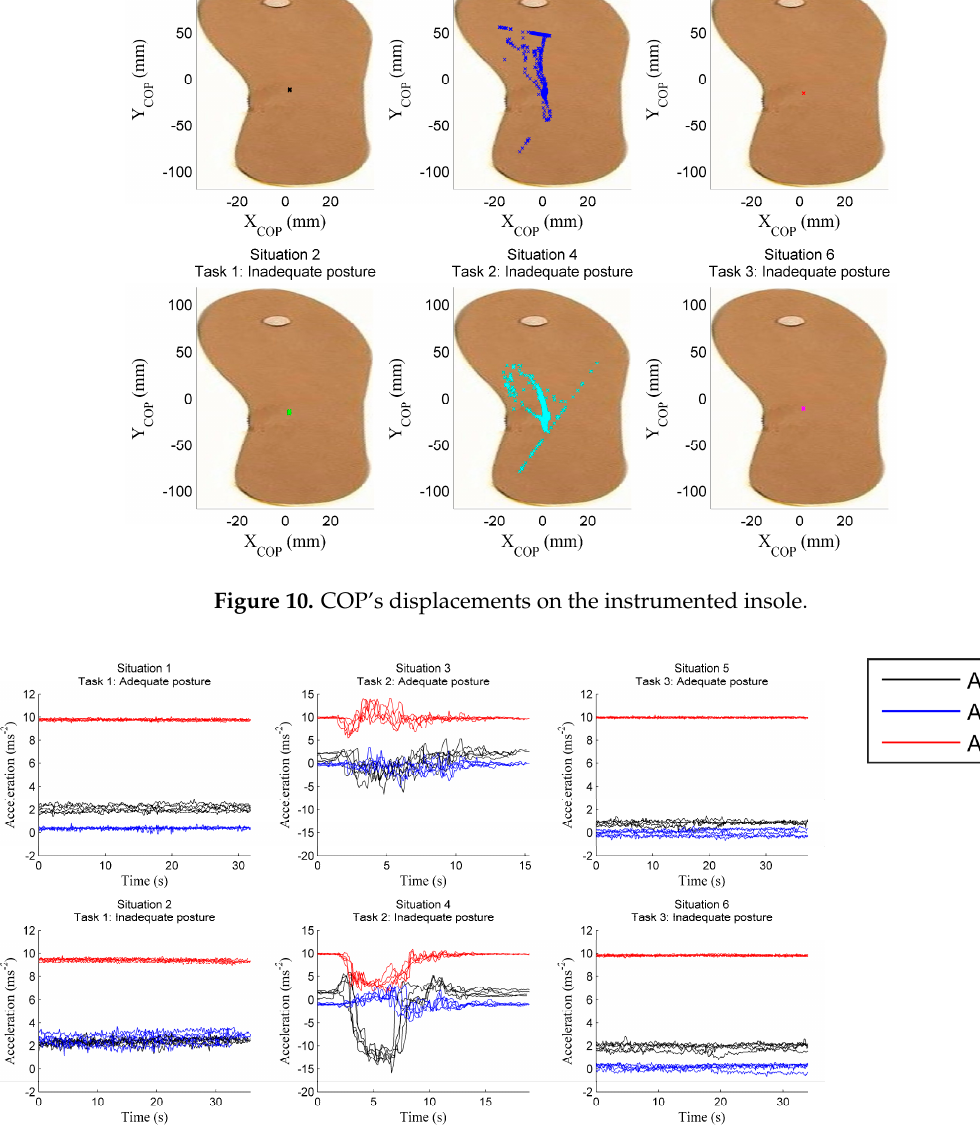
Figure 11. Acceleration signals of the head in three axes (five tests in each case).